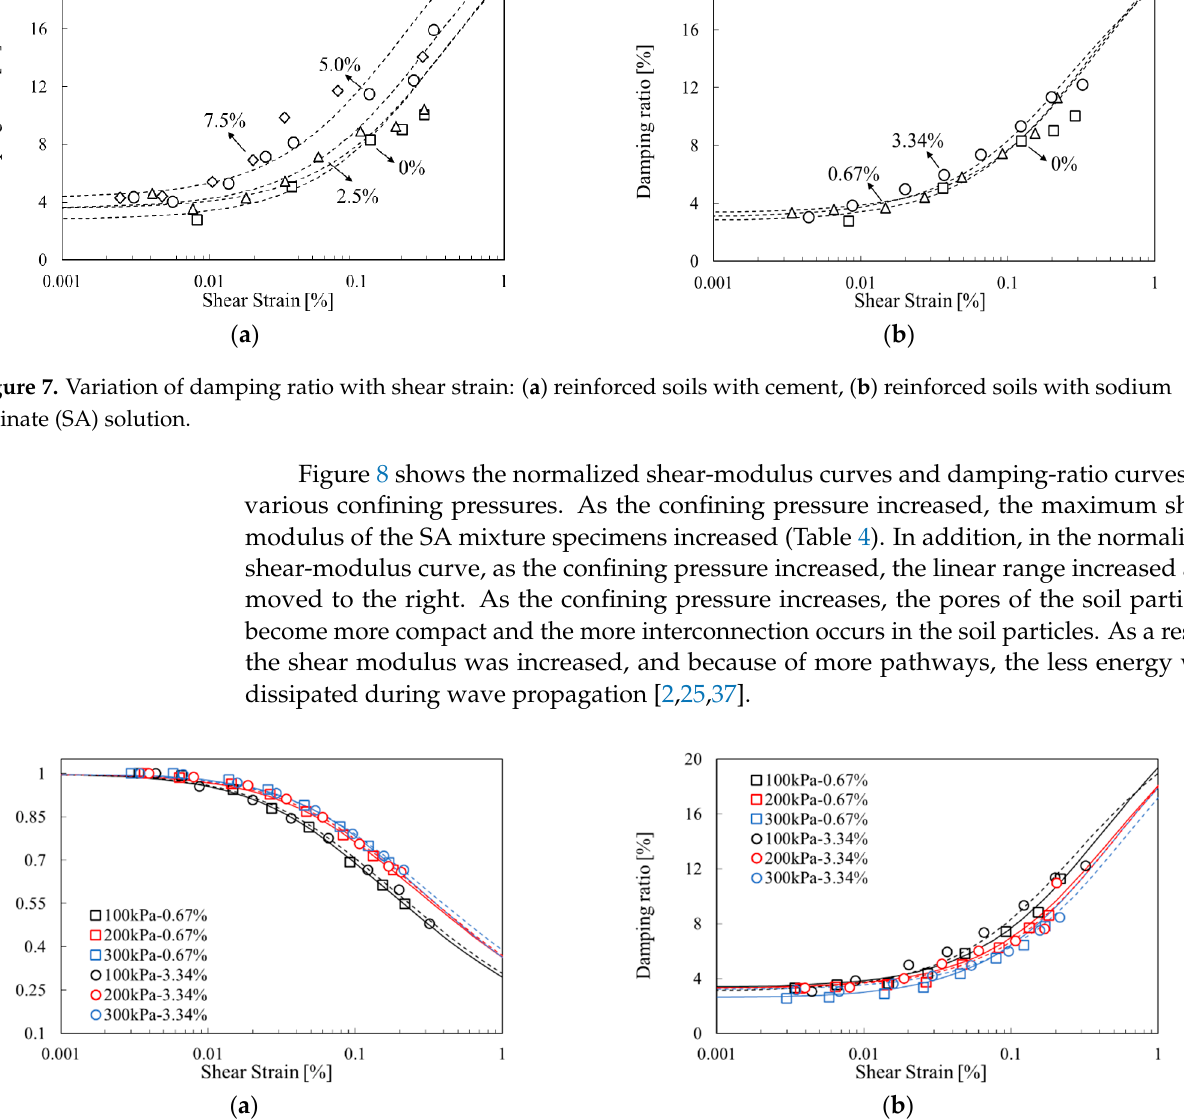
Table 5. Ramberg-Osgood model parameters.